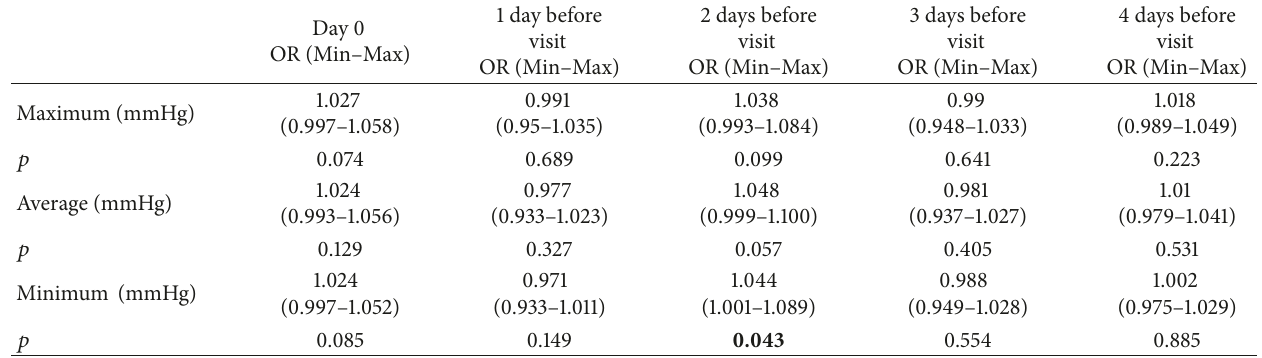
Table 8: Sea level pressure for 4 days before visit due to pneumonia.